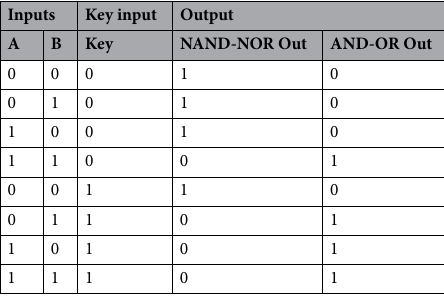
Table 4. Truth table for stack based encryption.